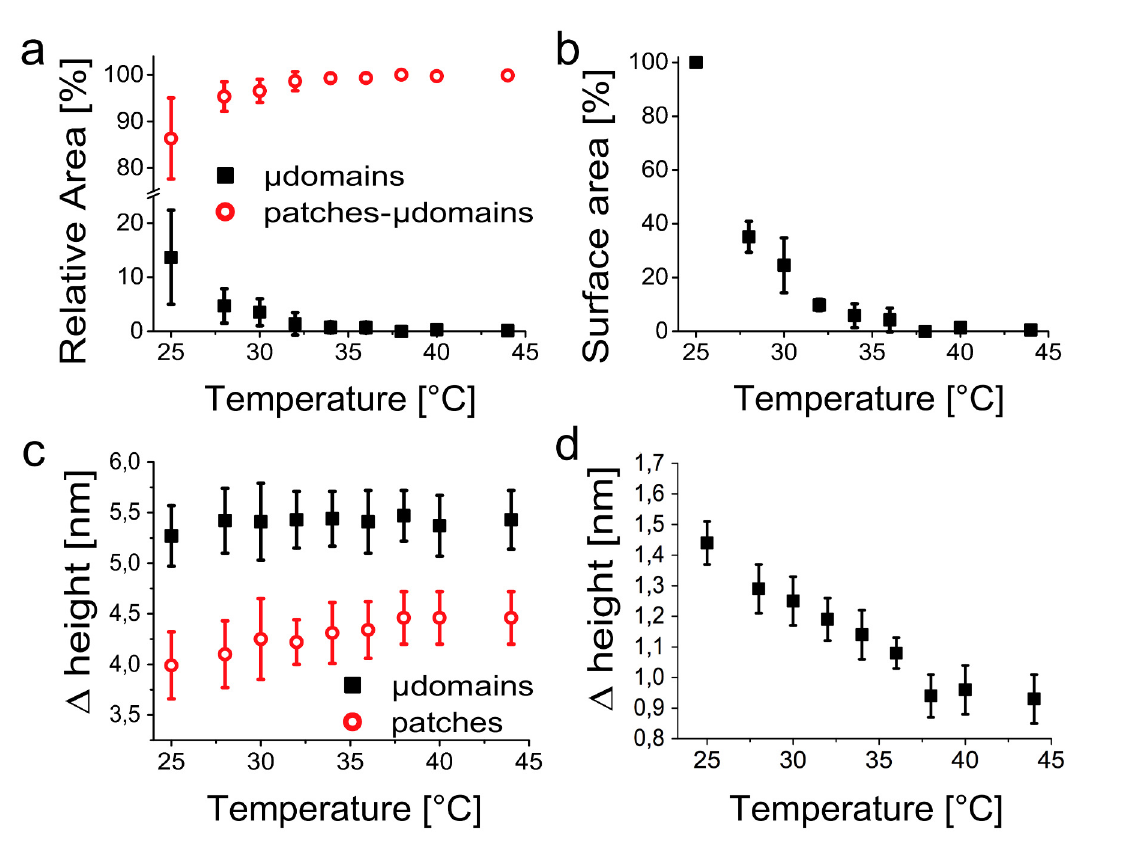
Fig 3. Temperature dependence of microdomain size and height. a , Plot of the relative areas of microdomains and membrane patches as a function of the temperature. b , Average of the surface area of individual microdomains as a function of temperature, normalized to the surface area of the respective microdomains at 25°C. c , Plot of the microdomain and membrane patch heights, both measured with respect to the mica, as a function of the temperature. d , Height of the microdomains measured with respect to the surrounding membrane patch surface, as a function of temperature. All data represent the mean ± SD obtained analyzing 16 different thermal